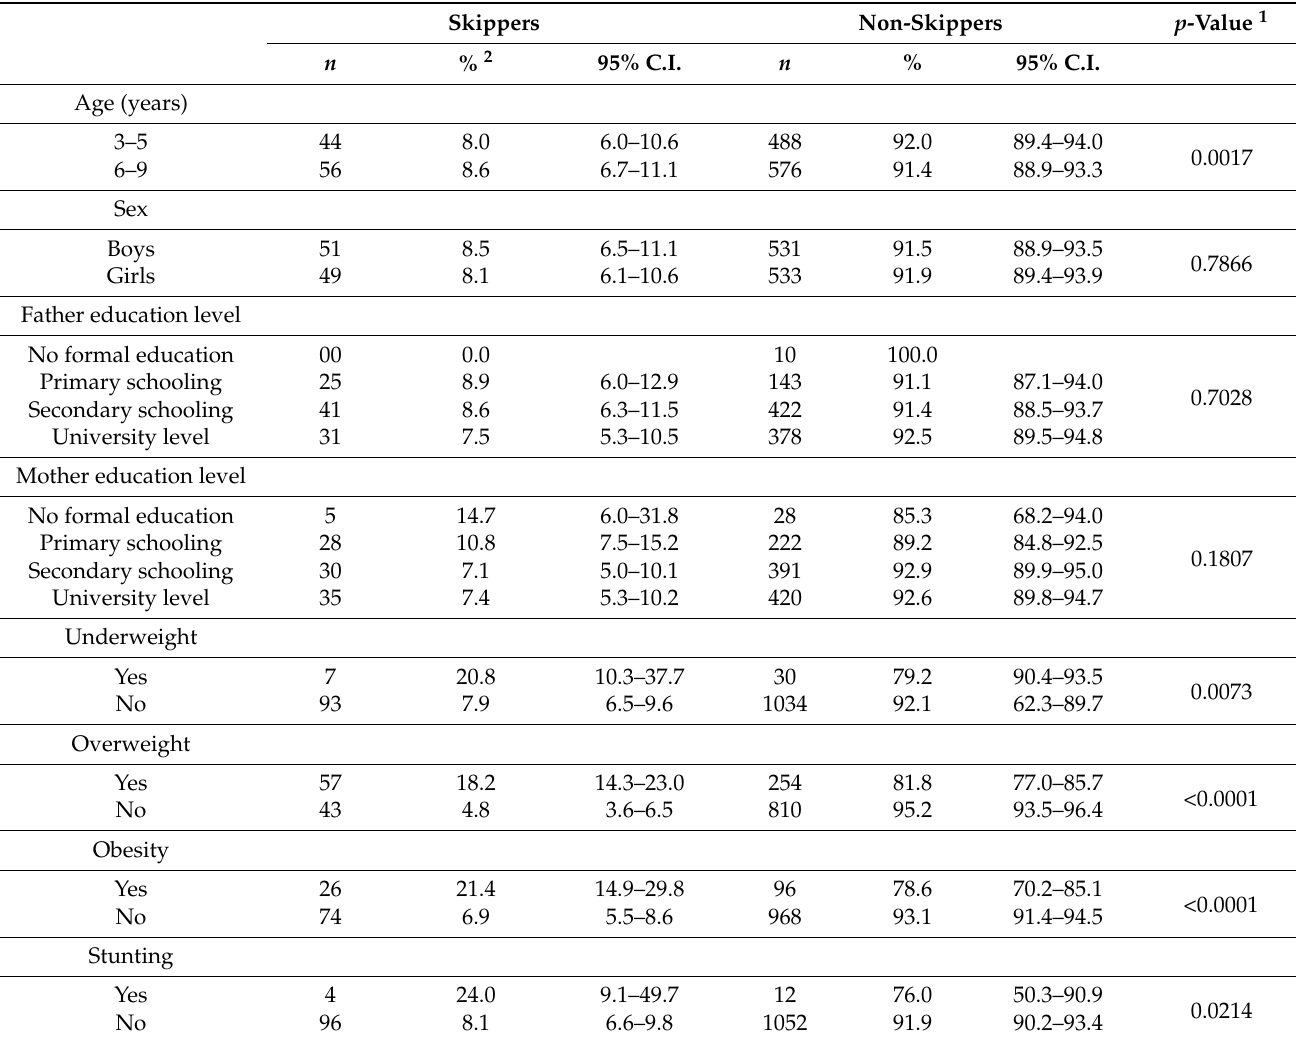
Table 2. Breakfast consumption of Tunisian children according to their socio-economic and anthropo- metric